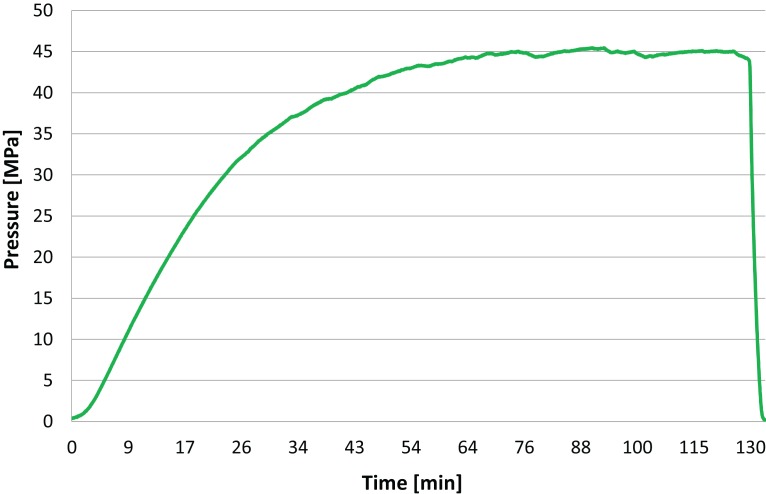
The pressure in the isochoric chamber was measured during the experiment with the pressure transducer in Fig. 2.This figure shows a typical pressure measurement over time in the isochoric system during the potato freezing experiment.